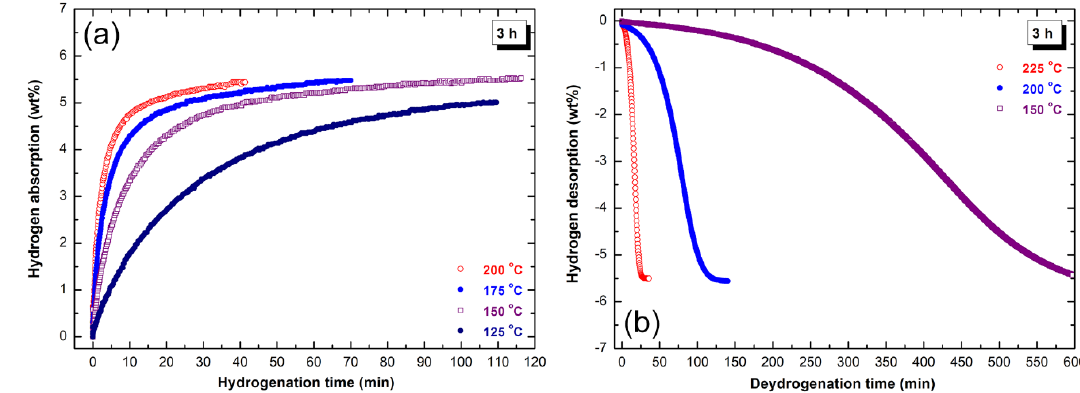
Figure 9. Kinetics of ( a ) hydrogenation and ( b ) dehydrogenation measured at different temperatures under hydrogen pressure of 10 bar and 200 mbar, respectively of rod-milled MgH 2 /7 wt% a-LaNi 3 for 3 h.